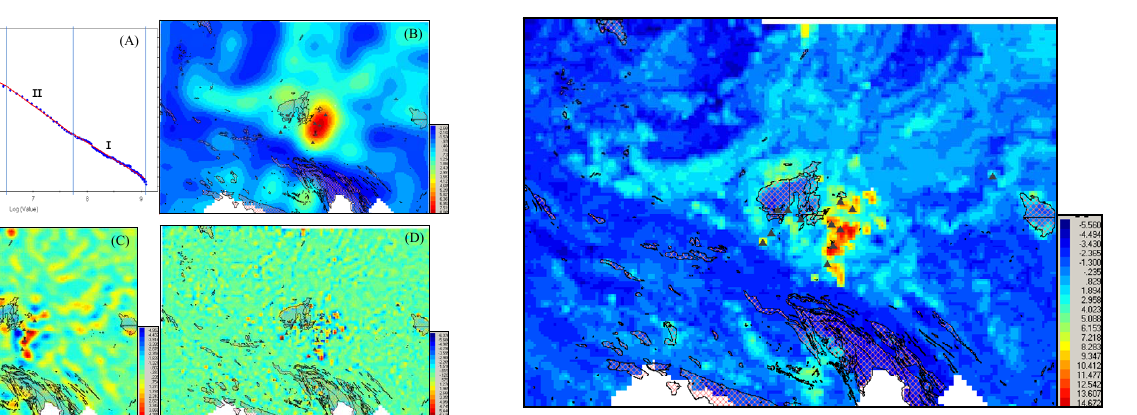
Fig. 4. Distribution of first principal component scores calculated using principal component analysis with a correlation coefficient matrix for the log-transformed values of the elements Sn, As, Zn, Pb, Zn and Cd. The loadings of these elements are similar and the first component accounts for 67% of the variance of the total dataset. The black polygons are mapped intrusions. The black triangles are tin mineral deposits.